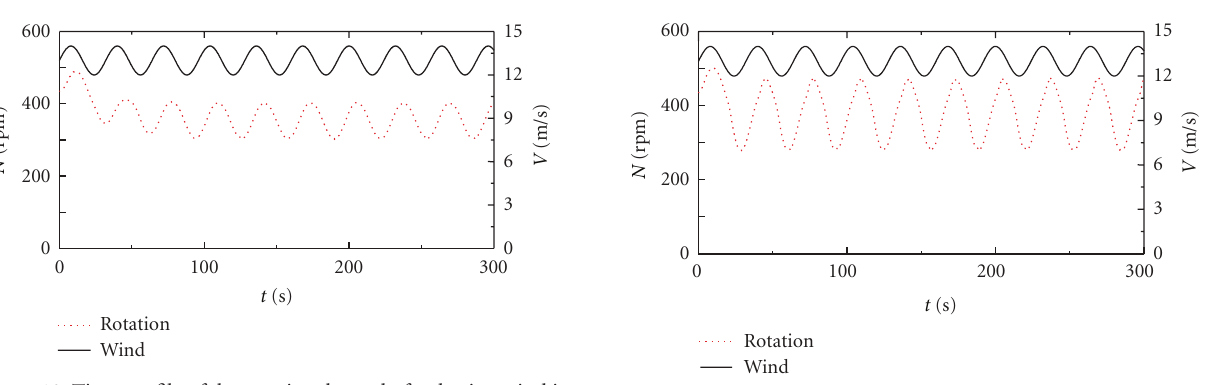
( I = 5 or 7 kgm 2 ). When the mean wind speed is large ( V 0 = 13 m/s), this tendency becomes more